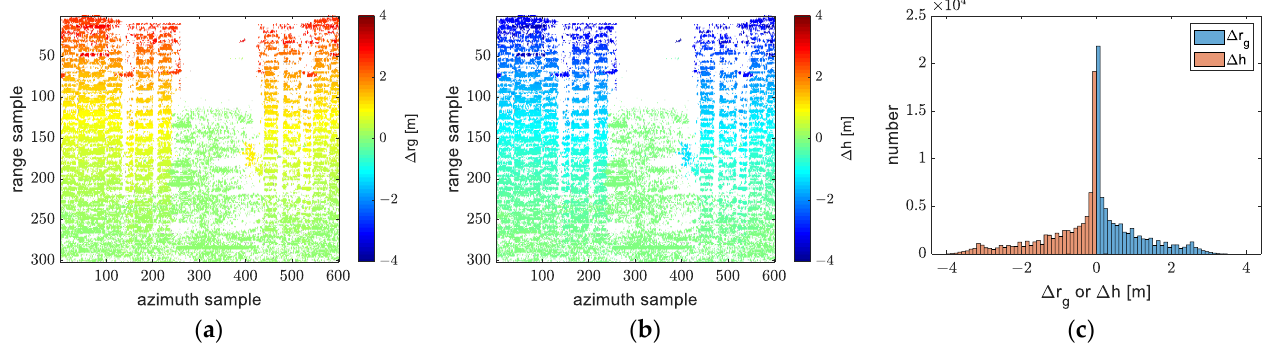
Figure 26. The ground range and height error between model 1 and model 5: ( a ) the ground range error; ( b ) the height error; ( c ) a histogram of the ground range and height error.